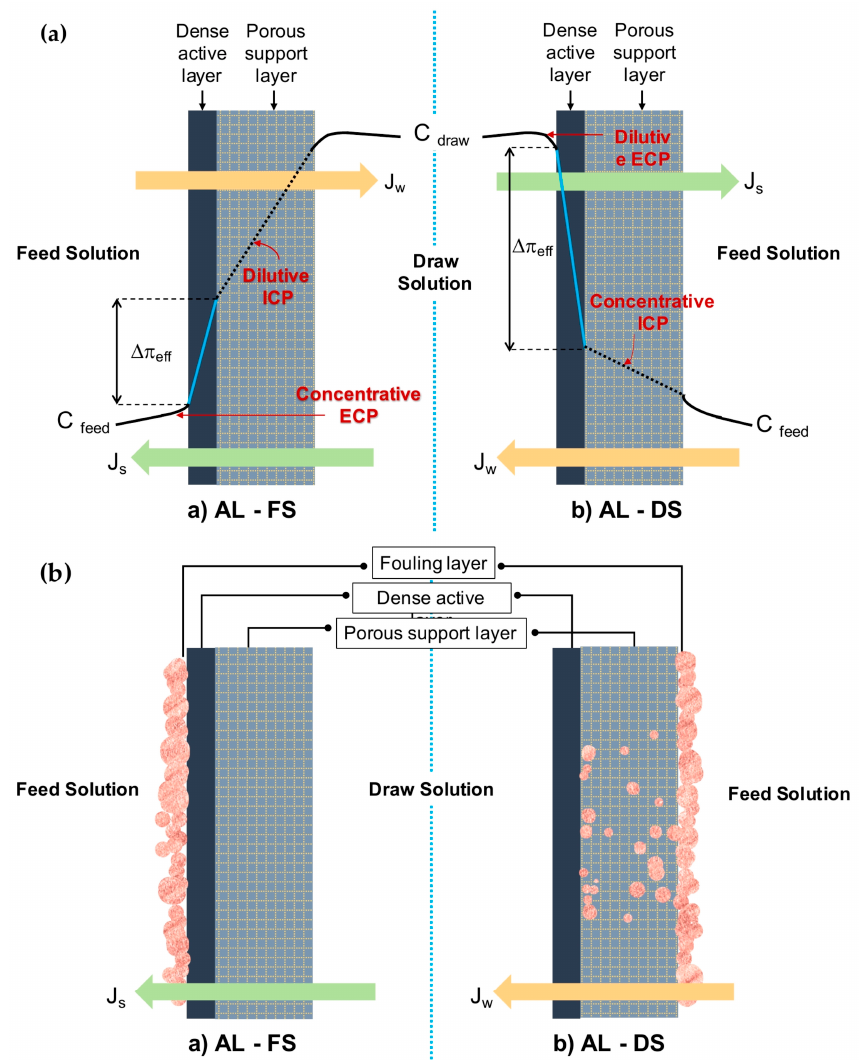
Figure 1. A conceptual illustration of the ( a ) membrane orientations AL-FS (active layer facing the feed) and AL-DS (substrate layer facing the feed) with a concentration polarization (CP) profile and ( b ) membrane fouling in forward osmosis (FO) membrane at di ff erent